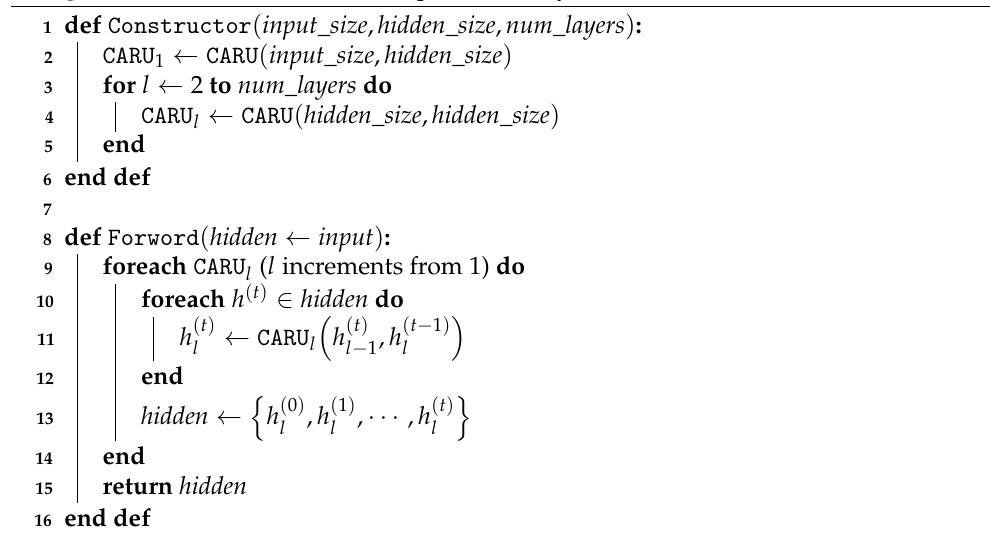
Algorithm 2: Pseudo code for complete multilayer